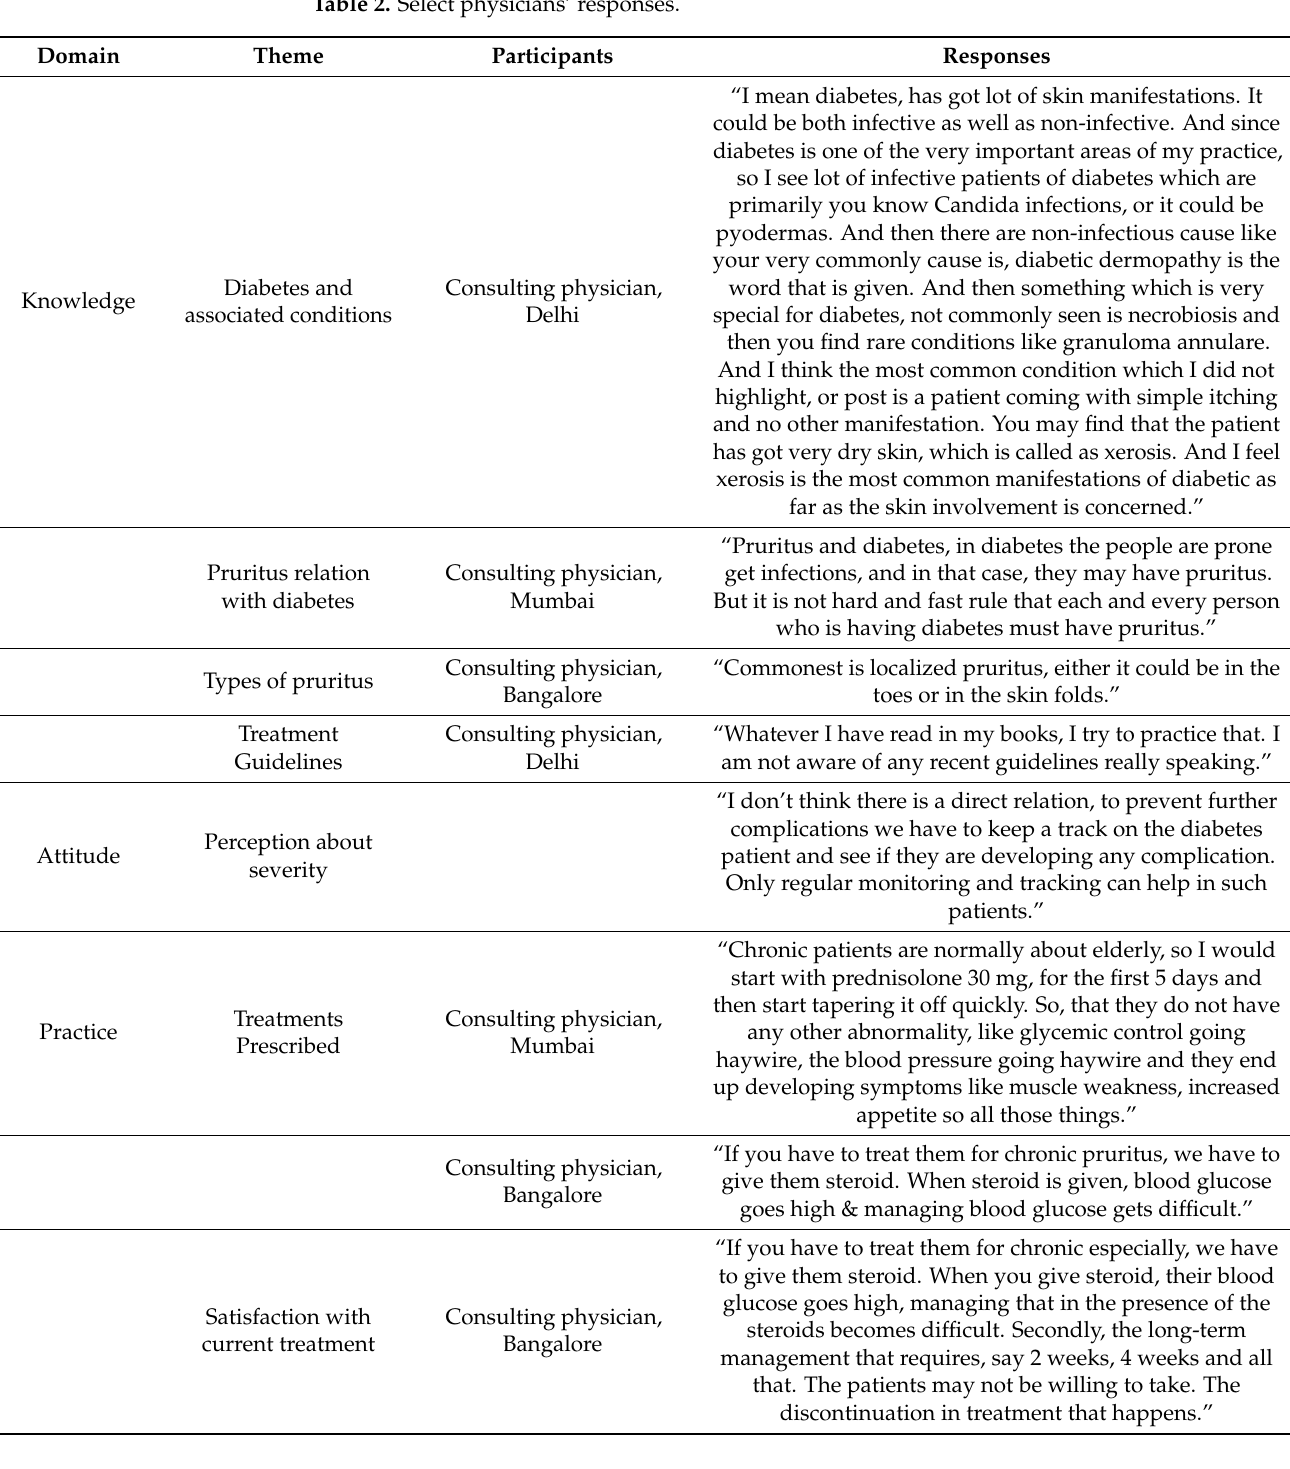
Table 2. Select physicians’